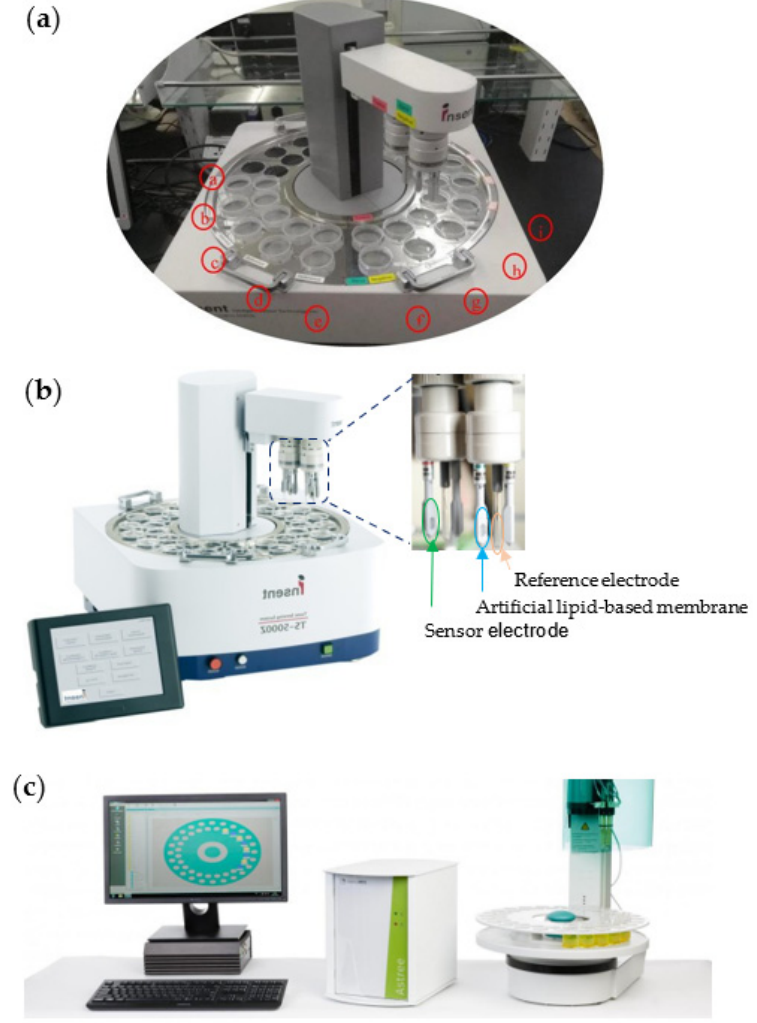
Figure 4. Images of three common potentiometric e-tongue systems for measuring the taste attributes of tea: ( a ) SA-402B (Intelligent Sensor Technology Co., Ltd., Japan; reprinted from Liu et al. [107]) (a, for measuring the aftertaste value; b and c, for cleaning the sample rapidly; d and e: for cleaning the positive and negative solution; f: for the positive and negative cleaning solution; g: for the sensor calibration; h: for sensor reset; i: for the liquor sample), ( b ) TS-5000Z (Insent Inc., Atsugi-Shi, Japan), and ( c ) ASTREE (Alpha MOS Inc., Toulouse, France).